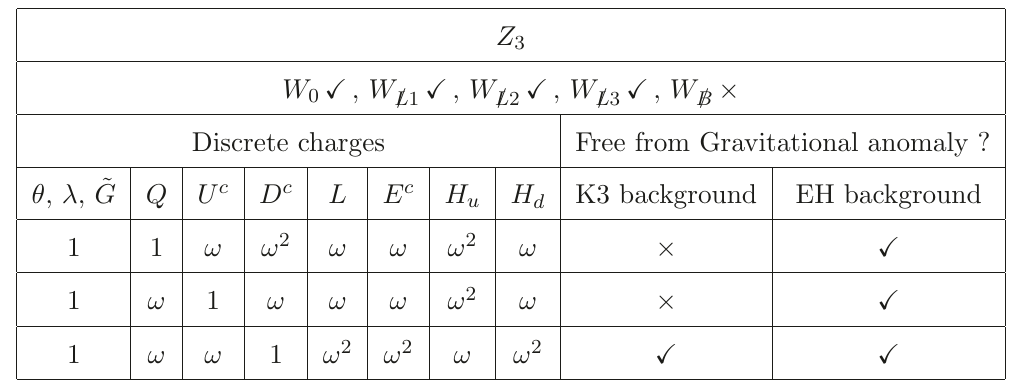
Table 5 . See the caption of table 2 for notations, and refer to the main text for more details. Solu- tions which can be obtained by the replacements ω → ω 2 and ω 2 → ω are removed from the